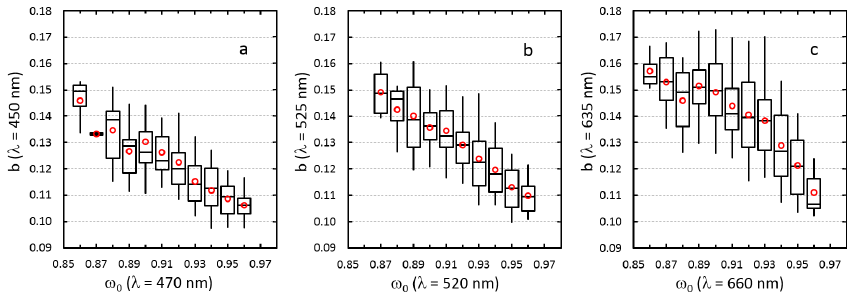
Figure 10. Daily averaged backscatter fraction ( b) of (a) blue, (b) green and (c) red light classified into 0.01 wide bins of the single-scattering albedo ( ω 0 ) . Note: b is that measured at the nephelometer wavelengths 450, 525 and 635nm and ω 0 is that at the aethalometer wavelengths 470, 520 and 660nm. The box plots present the 5th, 25th, 50th, 75th, and 95th percentiles and the circles the averages in each bin.